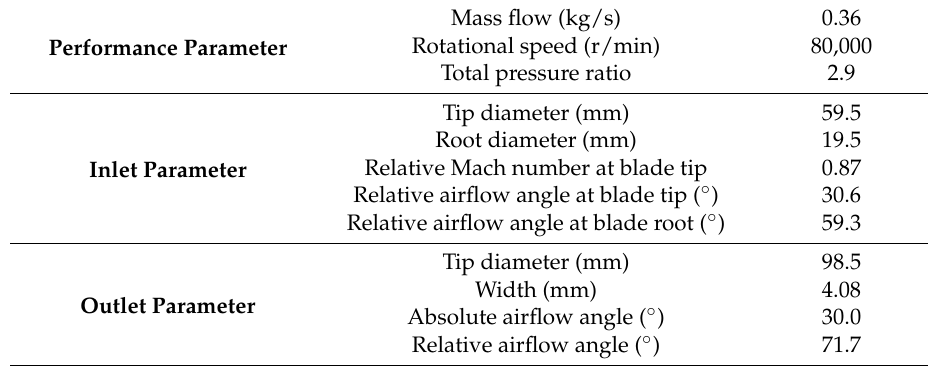
Table 1. Geometric and aerodynamic parameters of